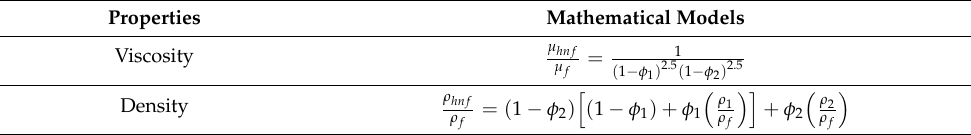
Table 2. The thermophysical properties of Hybrid Nanofluid